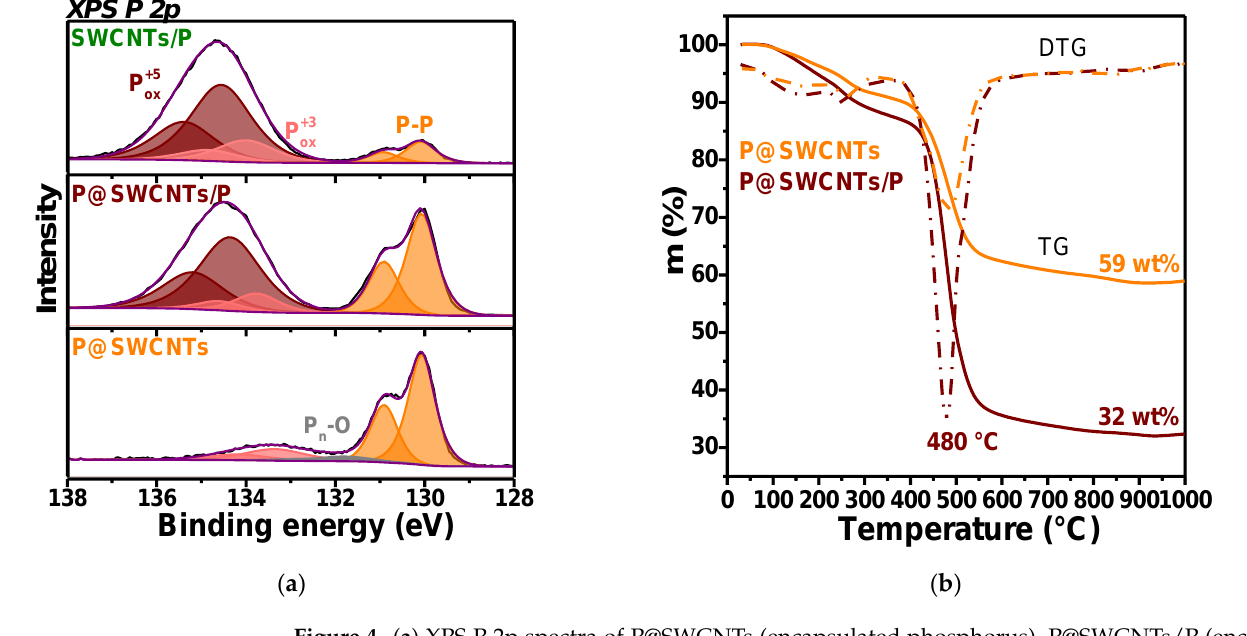
Figure 4. ( a ) XPS P 2p spectra of P@SWCNTs (encapsulated phosphorus), P@SWCNTs/P (encapsulated and external phosphorus) and SWCNTs/P (external phosphorus); ( b ) TG and DTG curves measured for P@SWCNTs/P and P@SWCNTs in helium.